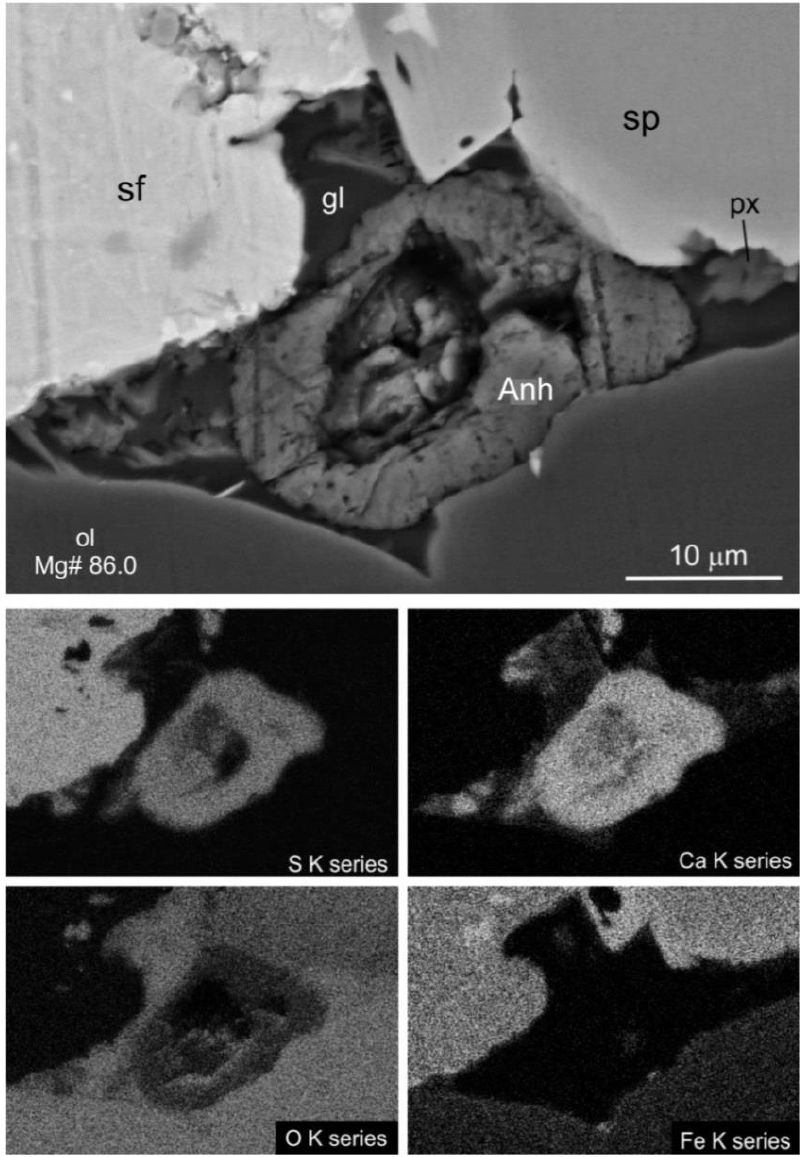
Figure 8. The element map (EDS) of the anhydrite globule is shown in Figure 7B. Anhydrite contains no other cations except calcium. Abbreviations are the same as in Figure 7.